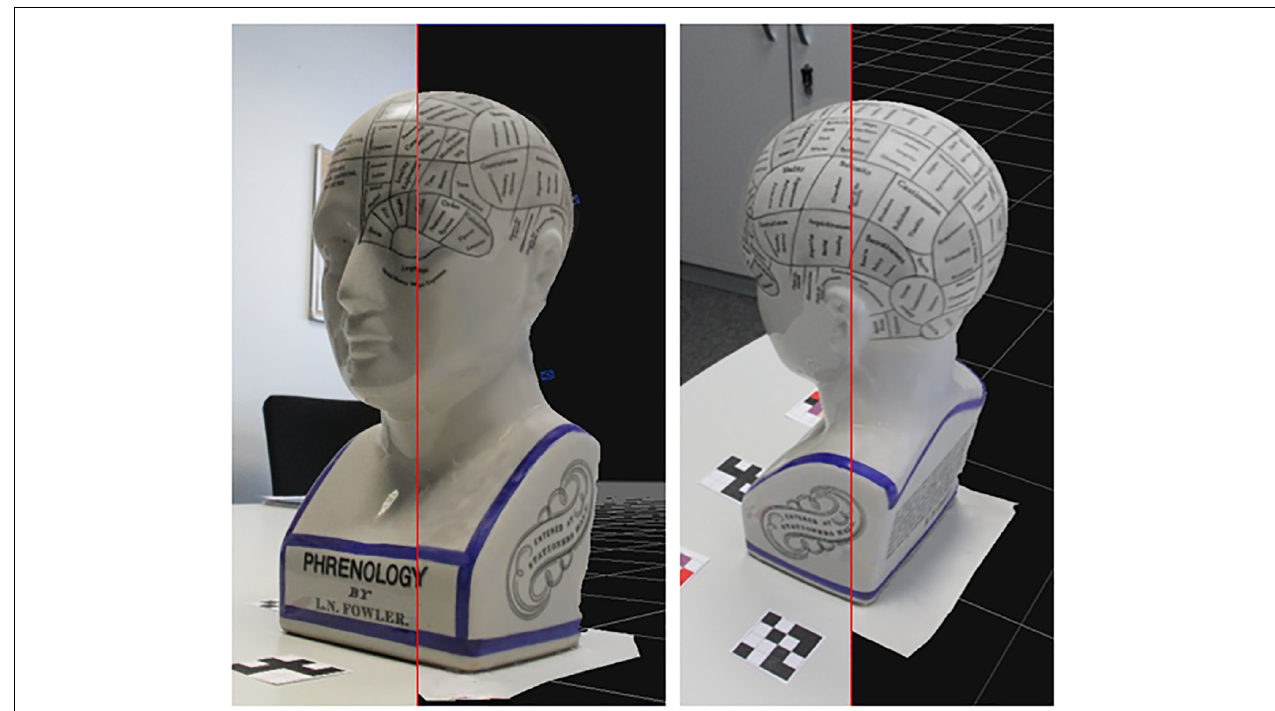
FIGURE 5 | A comparison of the physical object (left segment of the images) and the PR3DM (right segment of the images) ; no further enhancements (e.g., reflections) are used for this PR3DM rendering. Screenshots are taken in 3DF Zephyr Lite (3Dflow, 2019).